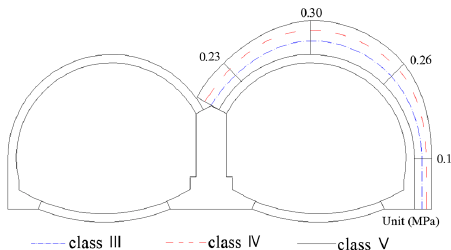
Figure 14. Final distribution of the contact pressures between surrounding rocks and primary linings in the cross sections in different classes of rock masses (class III, IV and V).